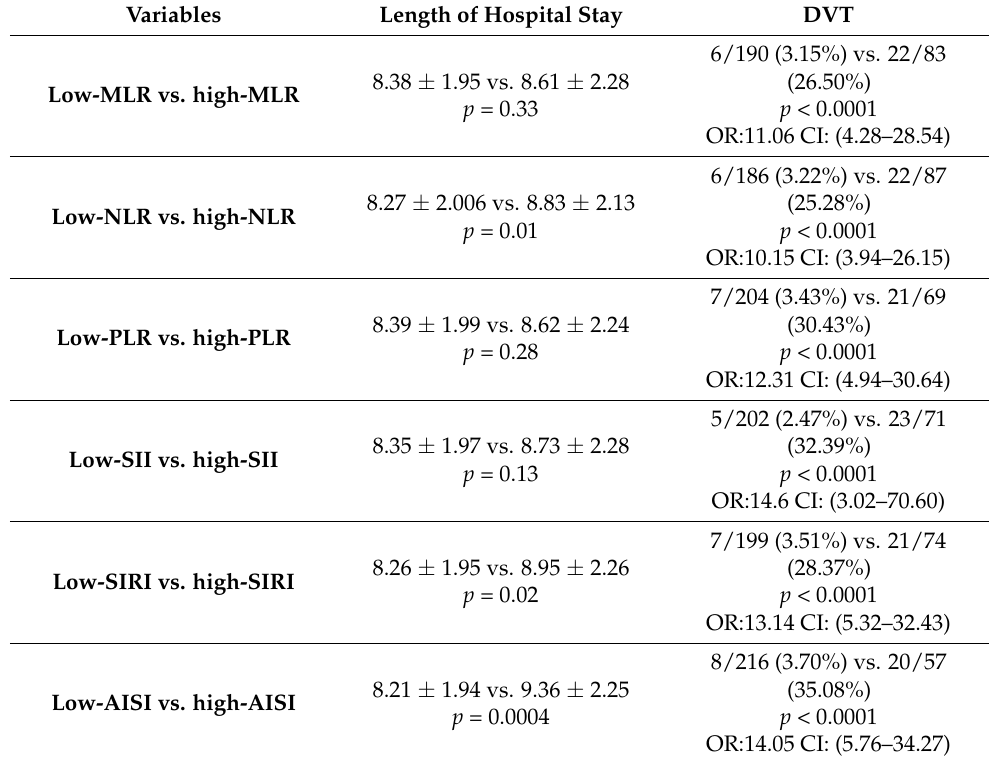
Table 3. Univariate analysis of hematological ratios and length of hospital stay and DVT risk.